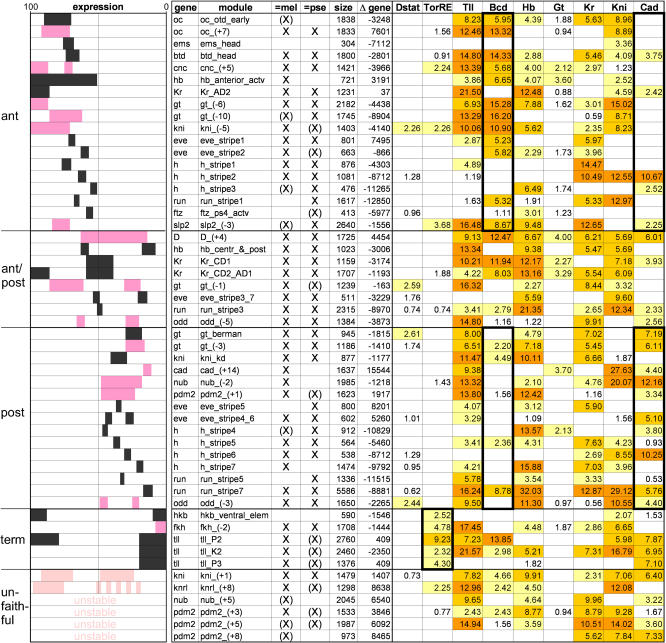
Correlation of Expression Patterns with Module CompositionBased on the expression pattern they give rise to, known and newly validated modules are sorted into anterior, posterior, and terminal (if expression bridges the 50% EL line, the module is labeled ant/post), and their binding site composition is evaluated using Ahab output from the mg run. The expression pattern of a module is depicted schematically (anterior = 100% EL, left; posterior = 0% EL, right), followed by name of gene, name of module, recovery as significant prediction (marked by X) or as subthreshold peak (marked by (X)) in D. melanogaster and D. pseudoobscura, distance to the gene's transcription start site (negative values denote upstream location), and binding site composition. For references see Dataset S1. Expression patterns of previously known modules are in black, those of newly validated modules are in dark pink, and modules with unfaithful/unstable patterns are in light pink. Binding site composition is given in the form of integrated profile values for individual input factors (see Materials and Methods); higher color intensity emphasizes higher values. Diagnostic features are emphasized by black trim: In anterior modules Bcd sites are overrepresented and Cad sites are underrepresented, while in posterior modules Cad sites are overrepresented and Bcd sites underrepresented. Terminal modules are enriched in TorRE sites.